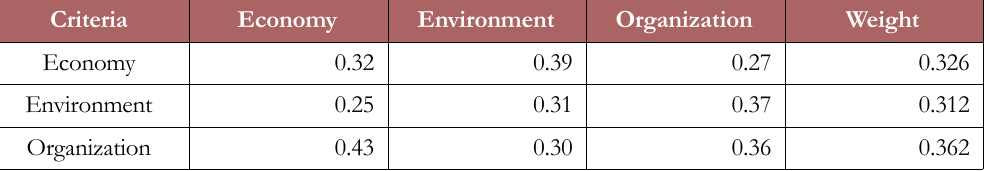
Table 4. Normalized Pairwise Comparison and Criteria